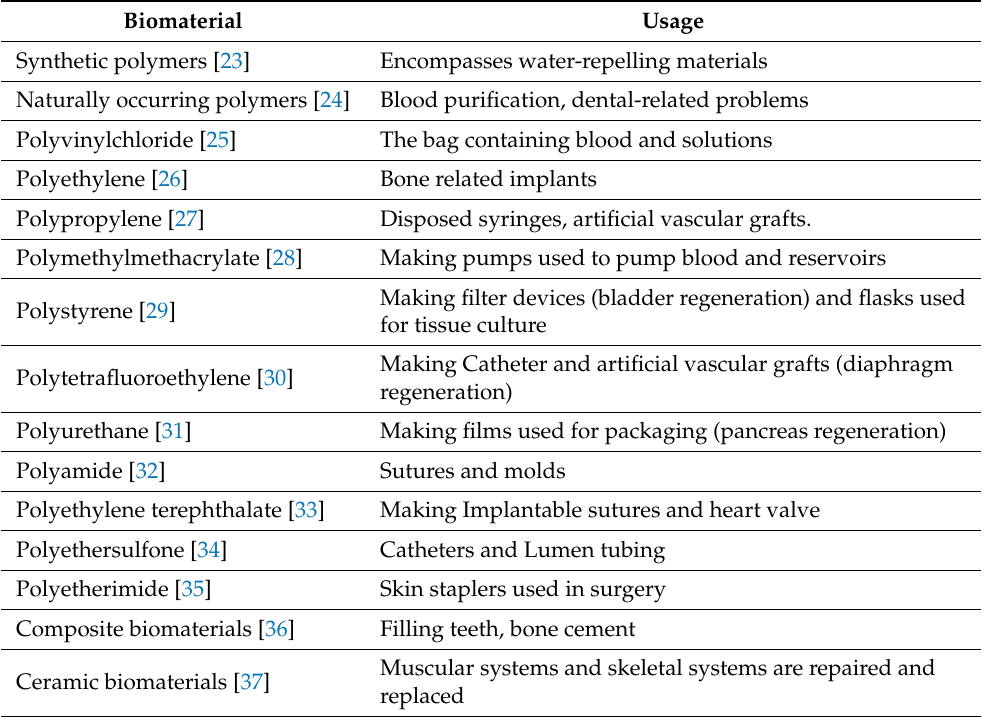
Table 1. Biomaterials and their